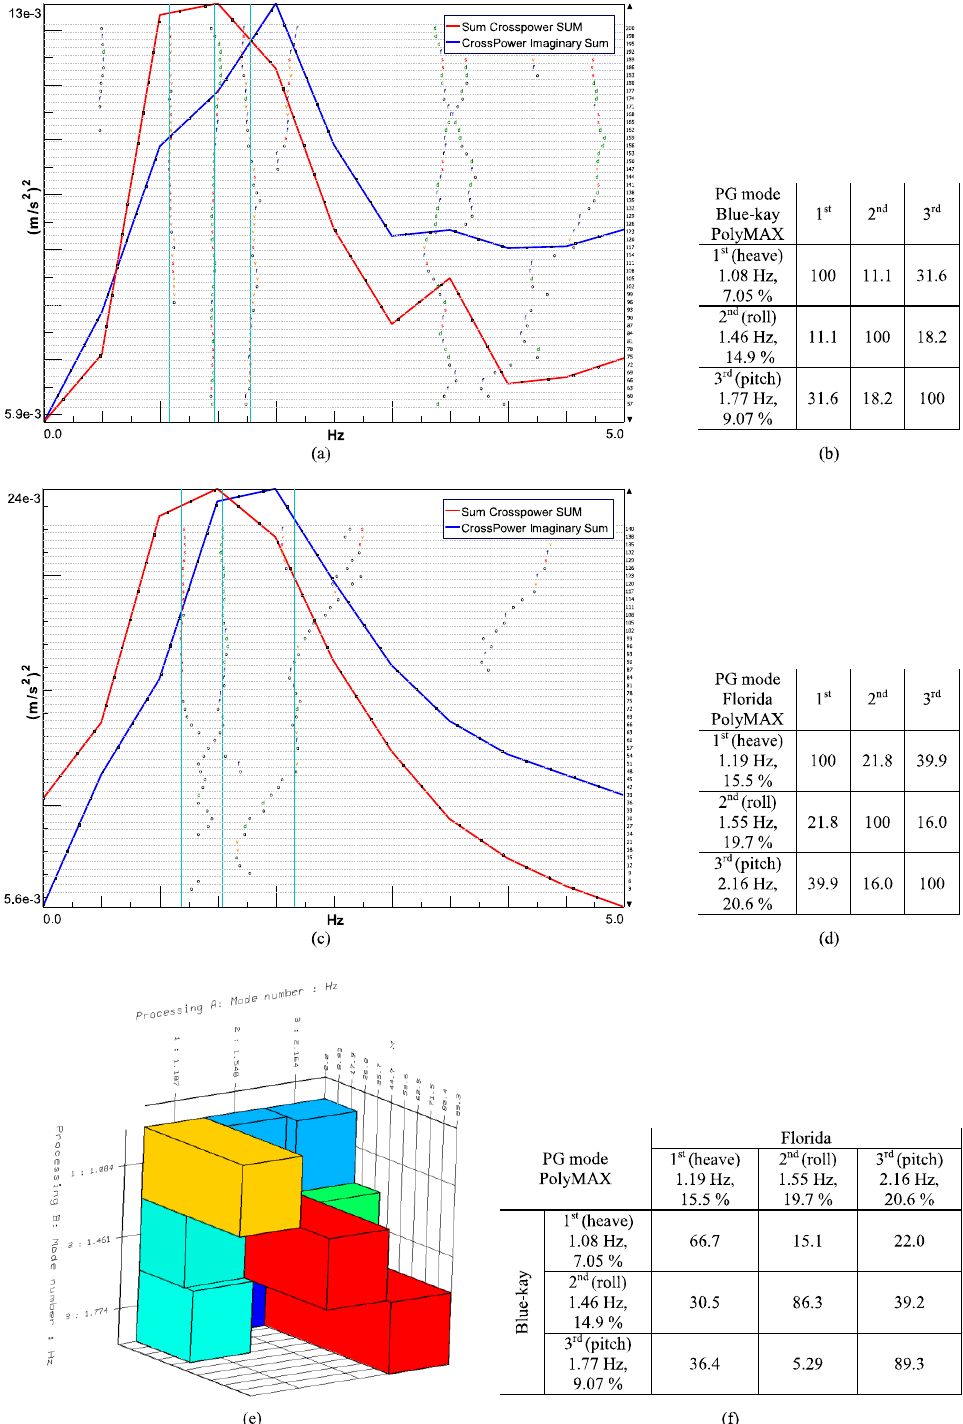
Fig. 7. Semi-active susp. car, proving ground tests: PolyMAX stabilisation diagrams and autoMAC tables in the Blue-kay (a, b) and Florida (c, d) cases. MAC matrix (e) and table (f) between those two mode set